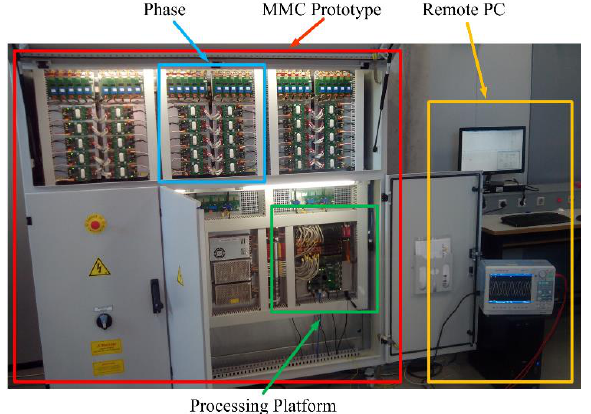
Figure 14. Modular Multilevel Converter Prototype. Table 2. MMC Prototype Parameters.